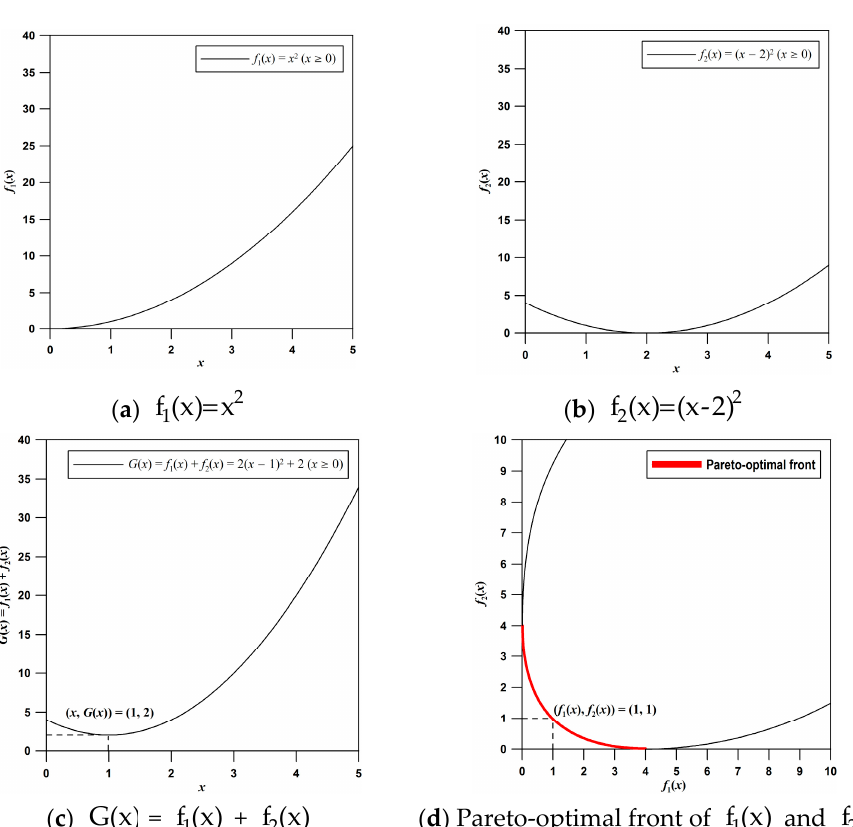
Figure 2. Comparison of global- and multi-objective optimization for a two-objective minimization problem. The global optimum obtained from global-objective optimization is (x, G ( x ) ) = (1, 2), which is neither the optimum for f 1 ( x ) nor the optimum for f 2 ( x ) . The global optimum is the closest Pareto-optimal solution from the origin under the given weights in objective space. Here, the origin is the ideal but infeasible solution.